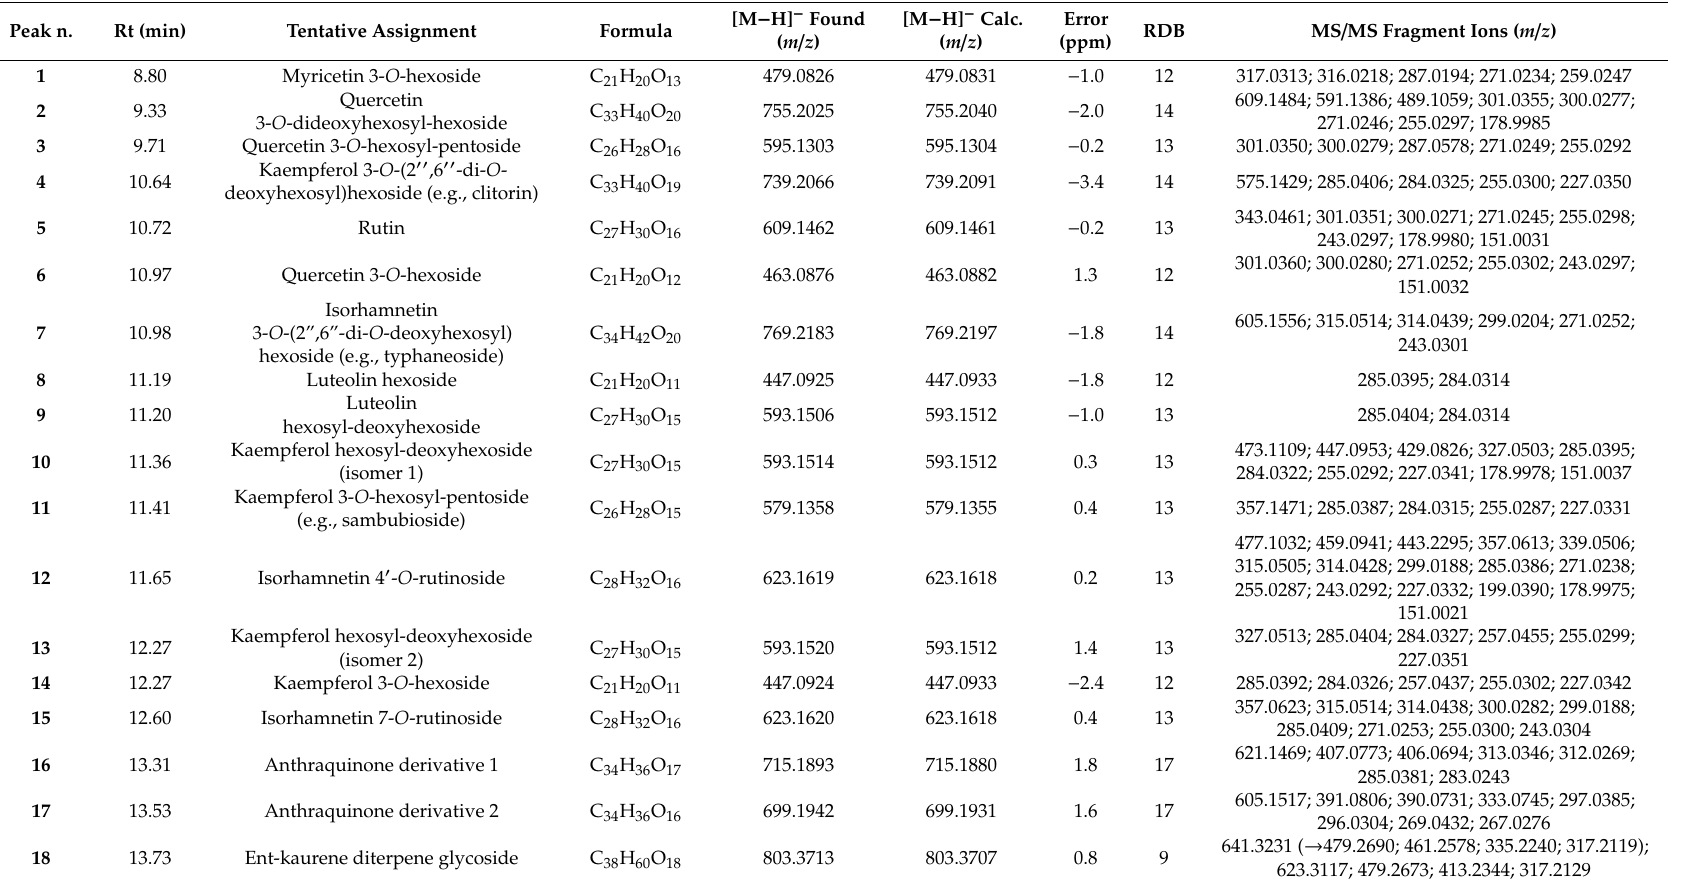
Table 1. TOF and TOF-MS 2 data of compounds tentatively identified in ZLF-A